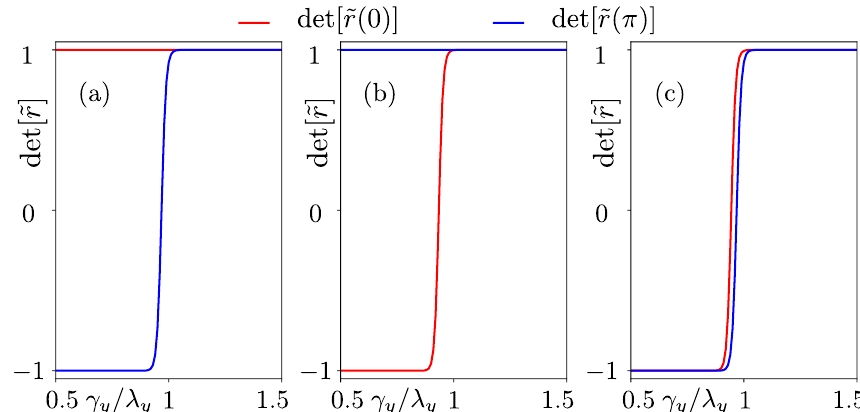
/λ , y y = 0.4 and γ = 1.2, respectively, x x = 0.5. sl